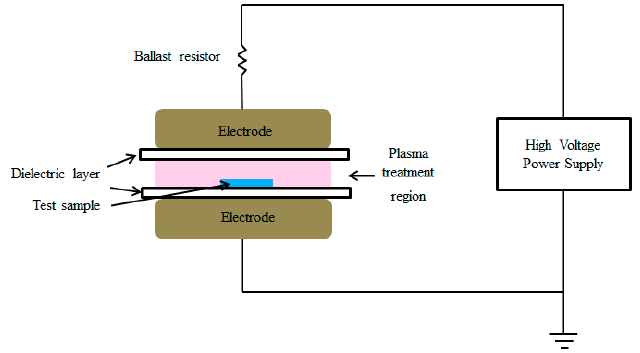
Figure 1. Schematic diagram of DBD for plasma treatment of test sample.